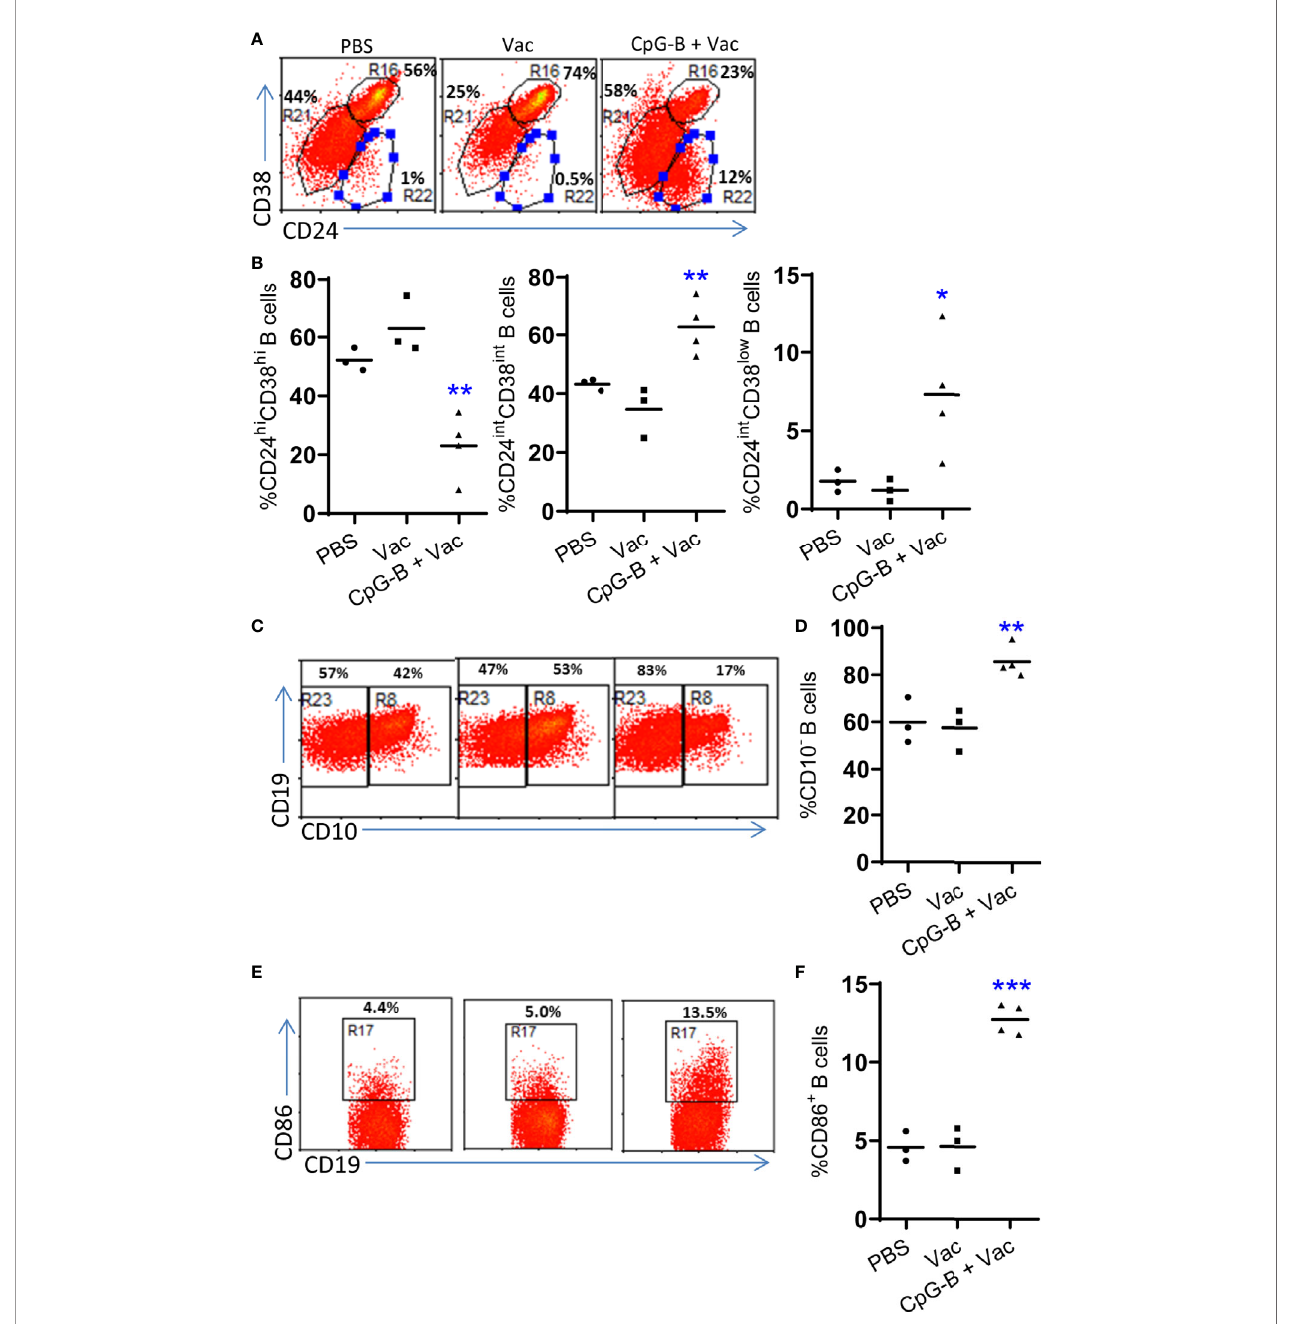
FIGURE 2 | CpG-B promotes maturation and activation of B cells in humanized mice. Humanized mice were vaccinated as in Figure 1 . The phenotype of human B cells (hCD45 + CD19 + ) from spleens of mice was detected by FACS. Representative dot plot (A, C, E) and Summarized data (B, D, F) showing the expression of CD38and CD24, CD10 and CD86 on human B cells. Each dot represents one individual mouse with n=3 in PBS group, n=4 in Vac group and n=4 in CpG-B plus Vac group. Bars indicate mean. *P < 0.05, **P < 0.01, ***P < 0.001, by unpaired, two-tailed Student ’ s t-test comparing the two vaccinated